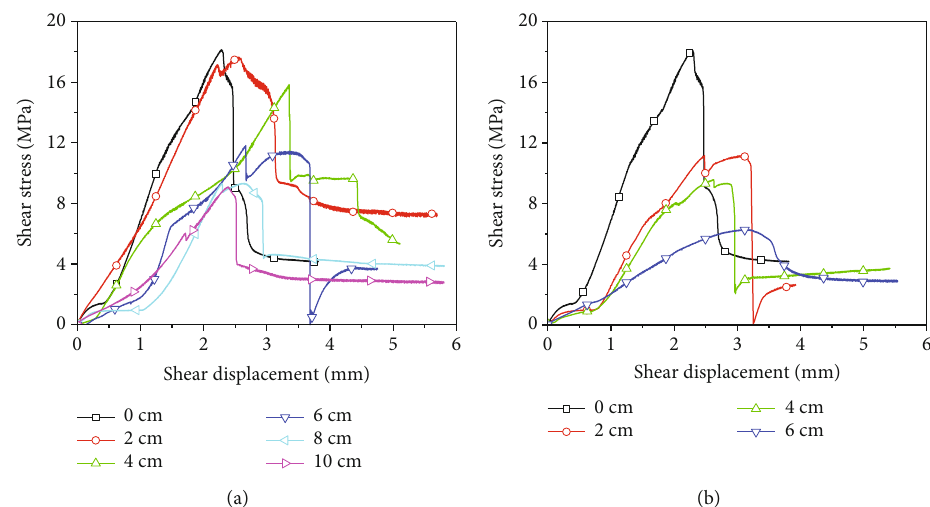
Figure 5: Curves of shear stress with respect to displacement of specimens with di ff erent cracks: (a) unilateral crack; (b) bilateral crack. Table 1: Peak shear strength of specimens with di ff erent cracks. Crack length (cm)